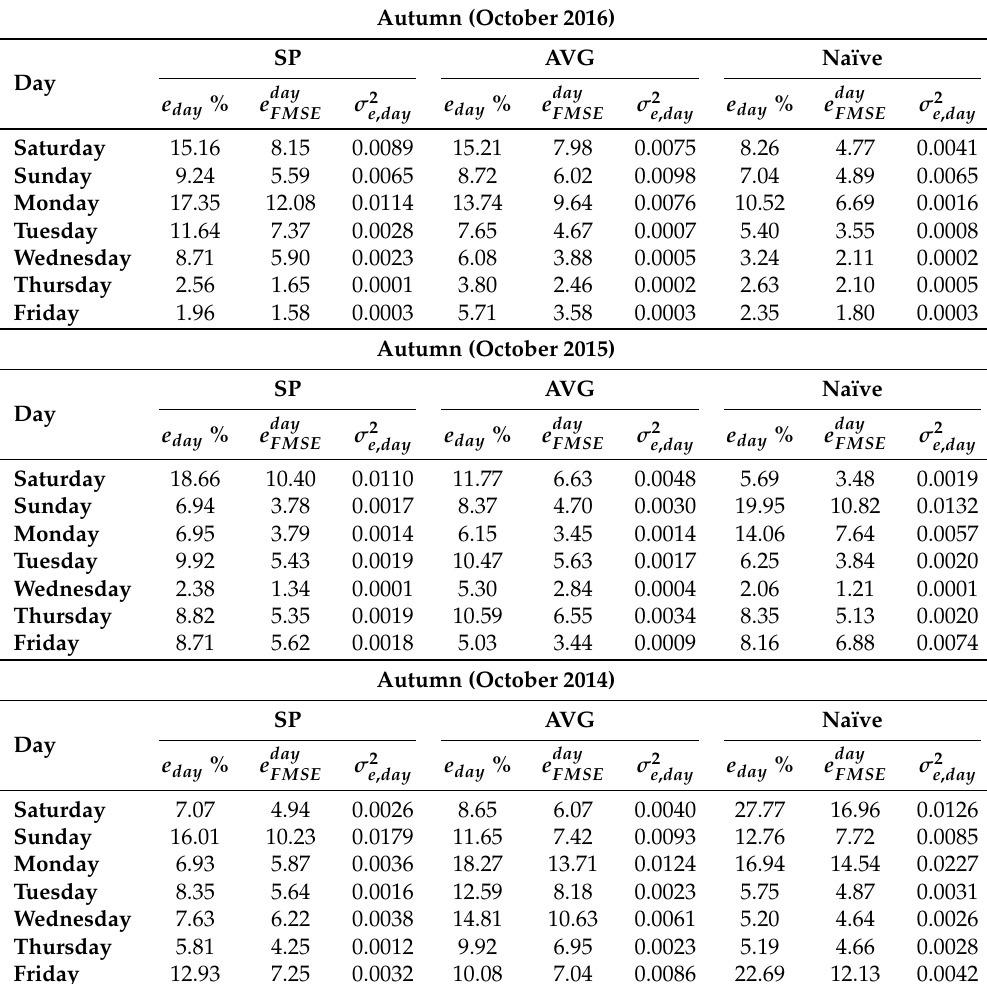
Table 10. e day (%), e day and naïve